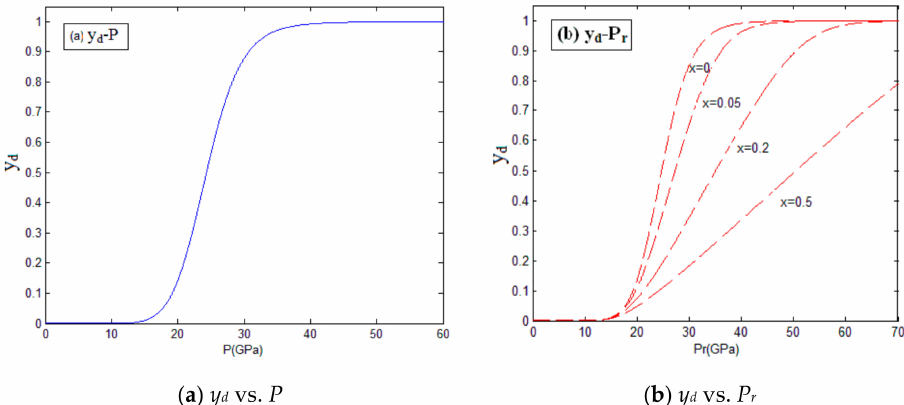
Figure 3. The relation between the degree of reaction and pressure. ( a ) The relation between the degree of reaction and pressure before material reaction; ( b ) The relation between the degree of reaction and pressure after material reaction.